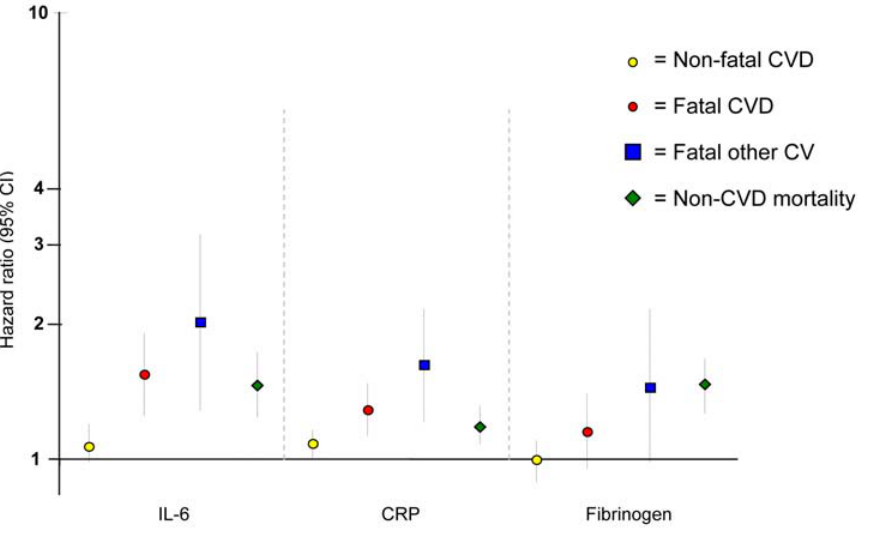
Figure 2. Plot showing associations of 1-unit increase in log IL-6, log CRP, and fibrinogen with HR of endpoints on a log scale (after adjusting for randomized treatment, age, gender, LDL cholesterol, HDL cholesterol, triglycerides, BMI, systolic and diastolic blood pressure, current and exsmoking, diabetes, previous CVD, use of antihypertensive therapy, and country).